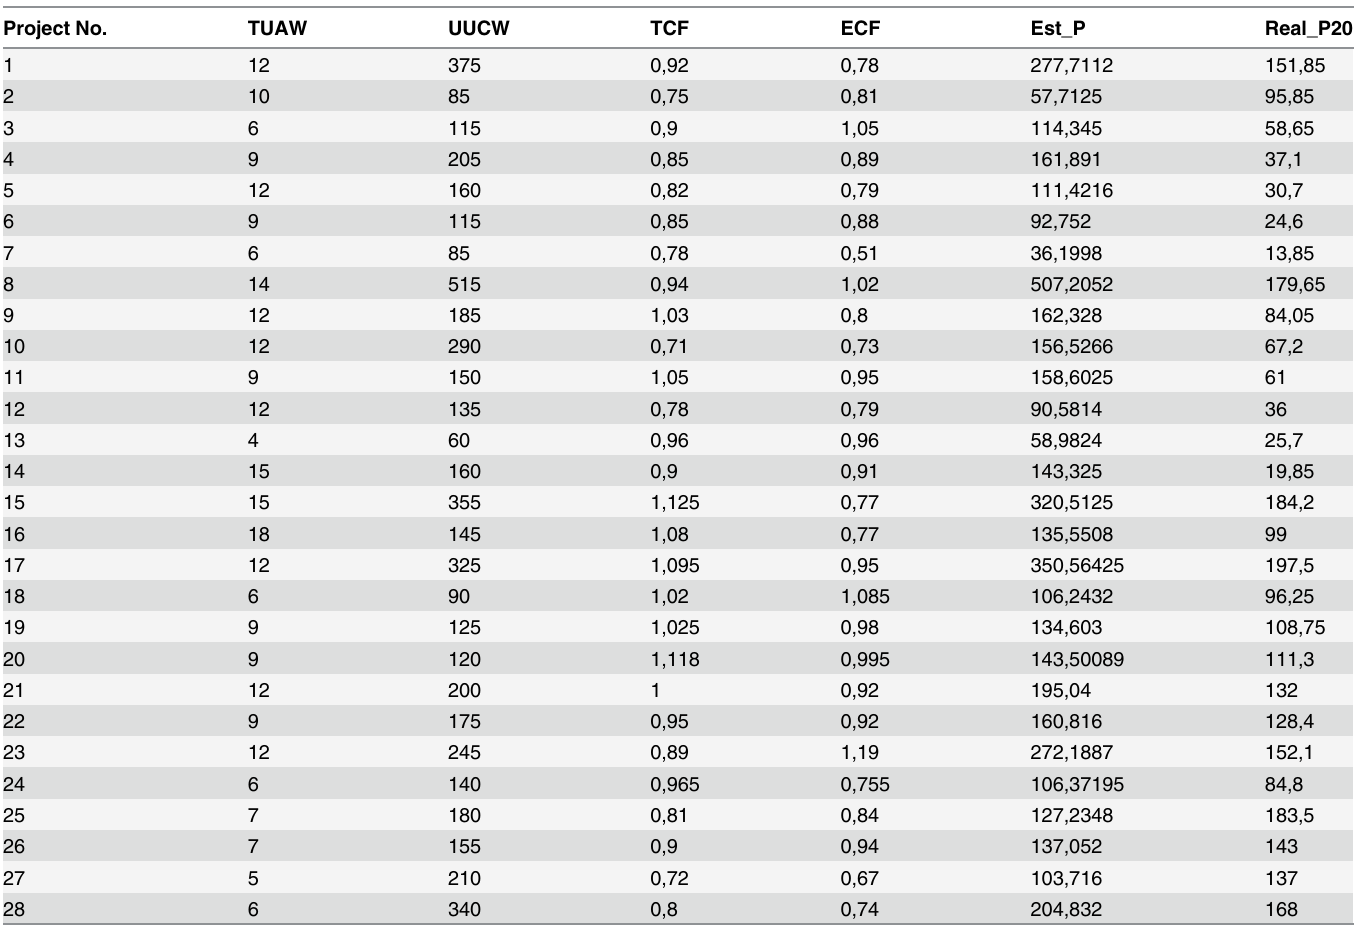
Table 5. Raw Project Data [9,